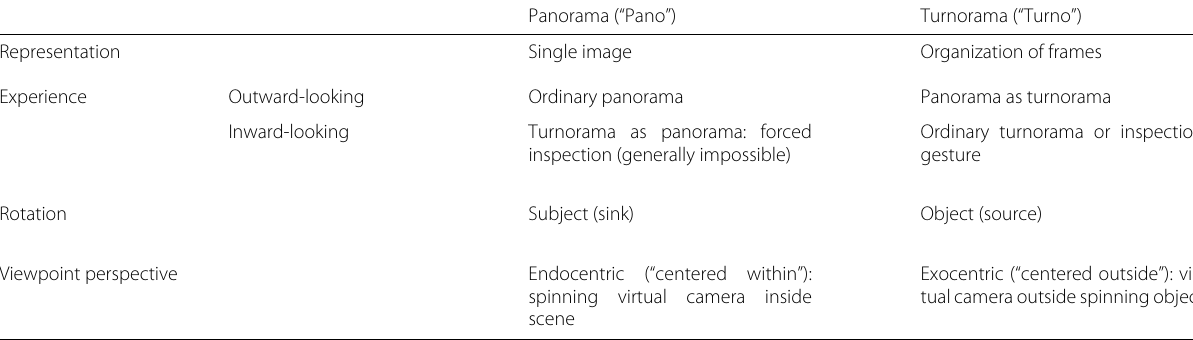
Table 2 Panoramic and turnoramic perspectives